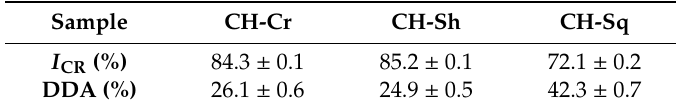
Figure 2. X-ray powder di ff raction (XRPD) patterns of CH-Cr, CH-Sh, and CH-Sq CH. Table 4. Crystalline index ( I CR ) and degree of deacetylation (DDA) of CH extracted from di ff erent sources.